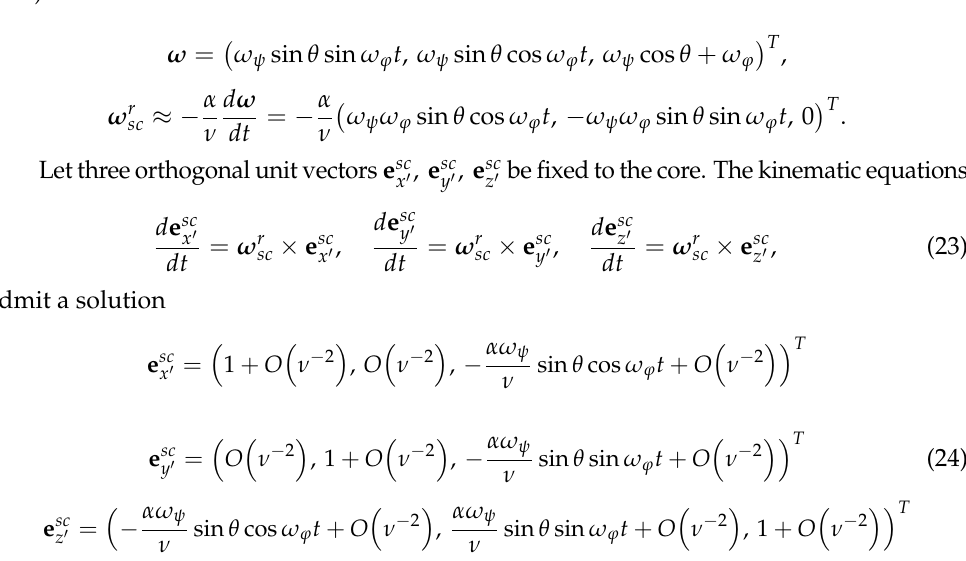
Figure 3. Velocity level lines in a plane through the instantaneous axis of relative rotation of the inner core (which is also the flow’s axis of symmetry) when I sc / I fluid = 1: ( a ) R sc / R lc = 0.6 > 1/ velocity of the liquid reaches its maximum on the surface of the inner core),( b ) R sc / R lc = 0.3 < 1/ (the maximal velocity of the flow is attained inside the